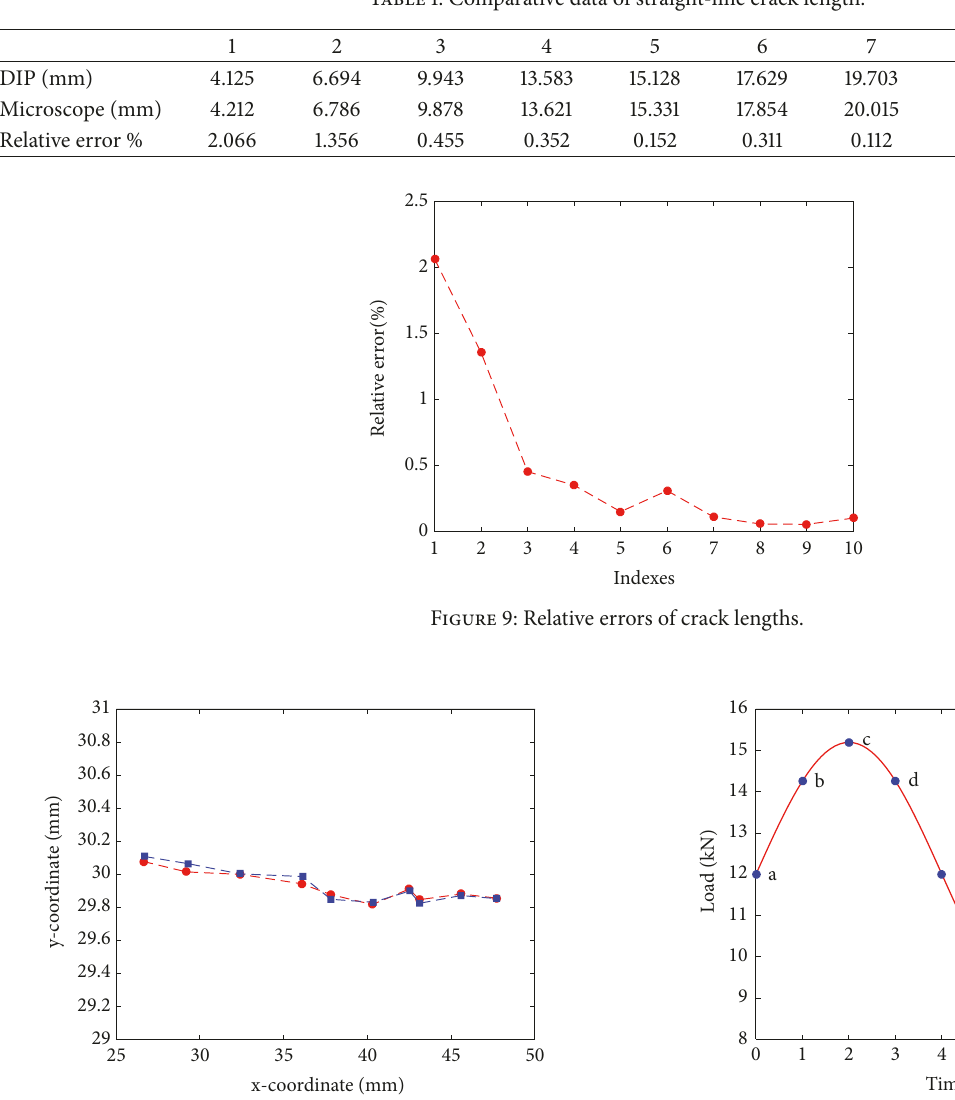
Table 1: Comparative data of straight-line crack length.